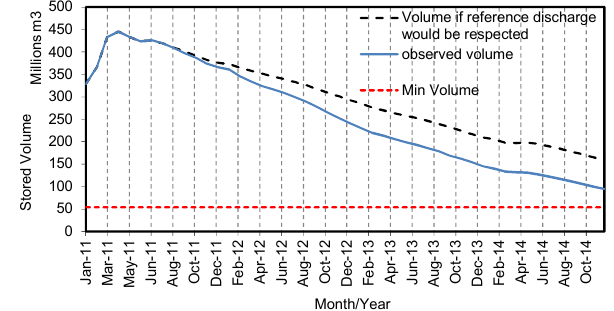
Figure 4. Observed and reference water storage of Epitácio Pessoa Reservoir (data source: AESA,